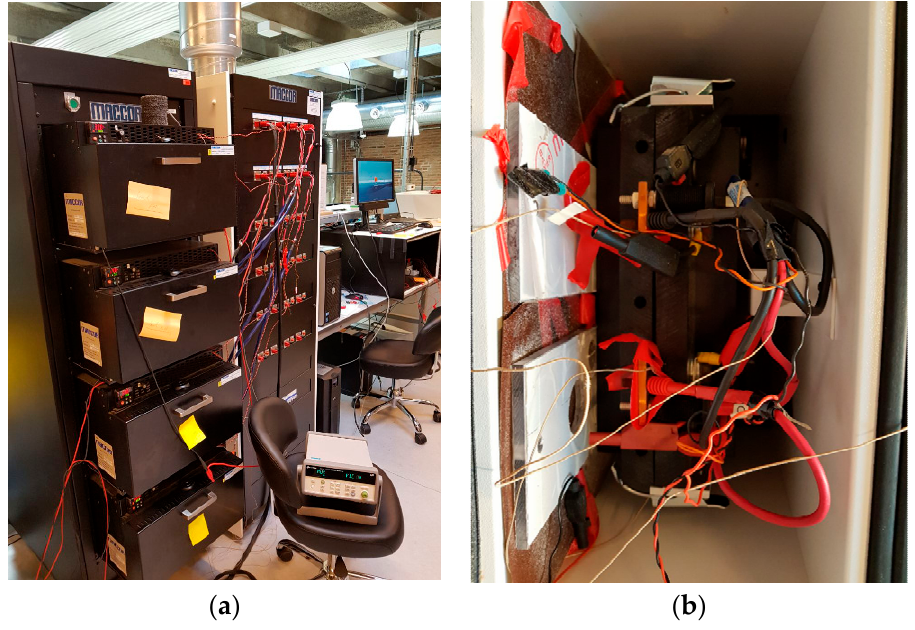
Figure 2. ( a ) Experimental setup; ( b ) battery inside chamber.